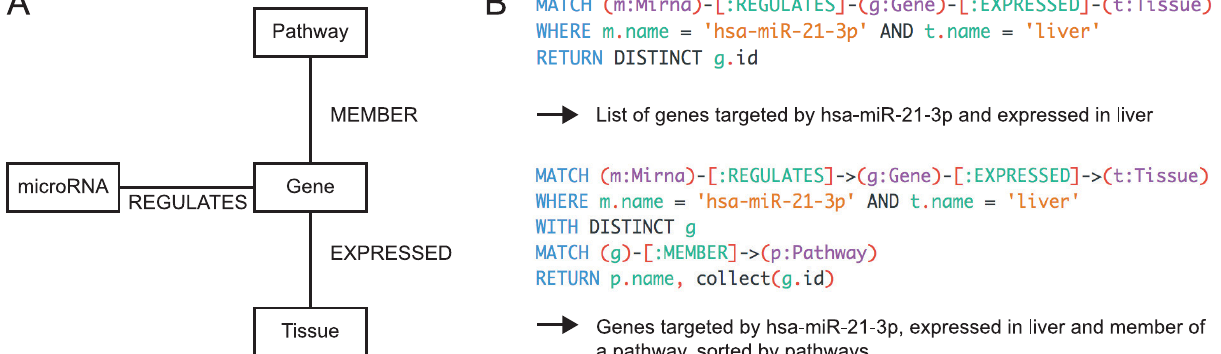
Fig 3. Database structure of miTALOS v2. (A) The miTALOS v2 dataset is stored in a graph database. The network structure allows for easy extension of the dataset. (B) The Cypher query language allows for simple queries on the network. With one query, the targets of a miRNA in a pathway can be accessed and filtered for tissue